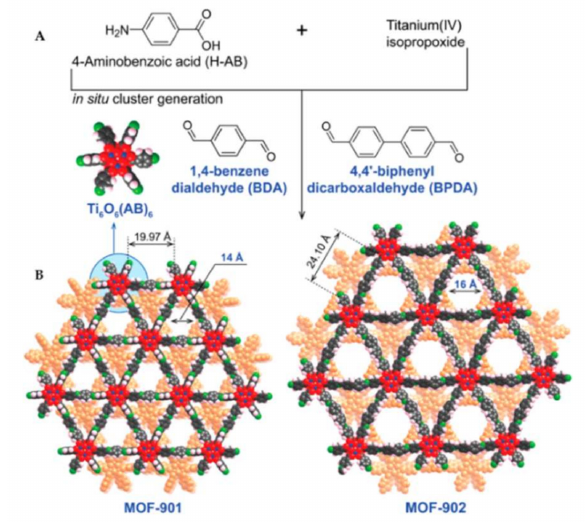
Figure 5. Synthetic procedure ( A ) and the structures ( B ) of MOF-901 and MOF-902 [71]. Copyright 2016, American Chemical